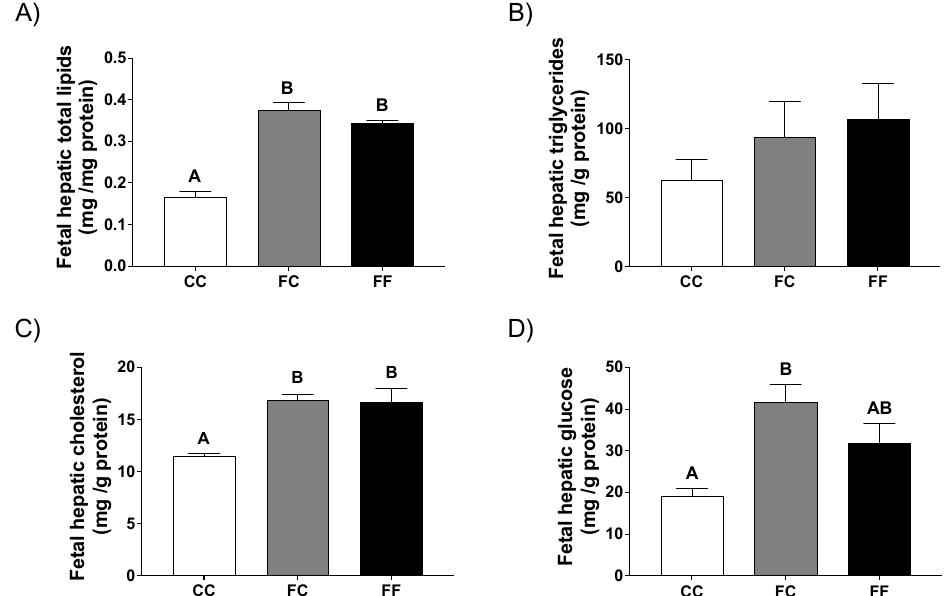
Figure 5. Pregnancy in progeny from fructose-fed mothers and ingestion of a 10% wt/vol fructose solution throughout gestation in pregnant rats from fructose-fed mothers influence fetal liver lipid accumulation. Hepatic content of ( A ) total lipids, ( B ) triglycerides, ( C ) cholesterol, and ( D ) glucose of fetuses from 21-day-pregnant rats from control mothers (CC, empty bar), or pregnant rats from fructose-fed mothers subjected (FF, black bar) or not (FC, grey bar) to fructose intake throughout pregnancy. Data are means ± S.E. from n = 5 liver pools of the fetuses of the same litter. Values not sharing a common letter are significantly different ( p < 0.05) between the three groups.